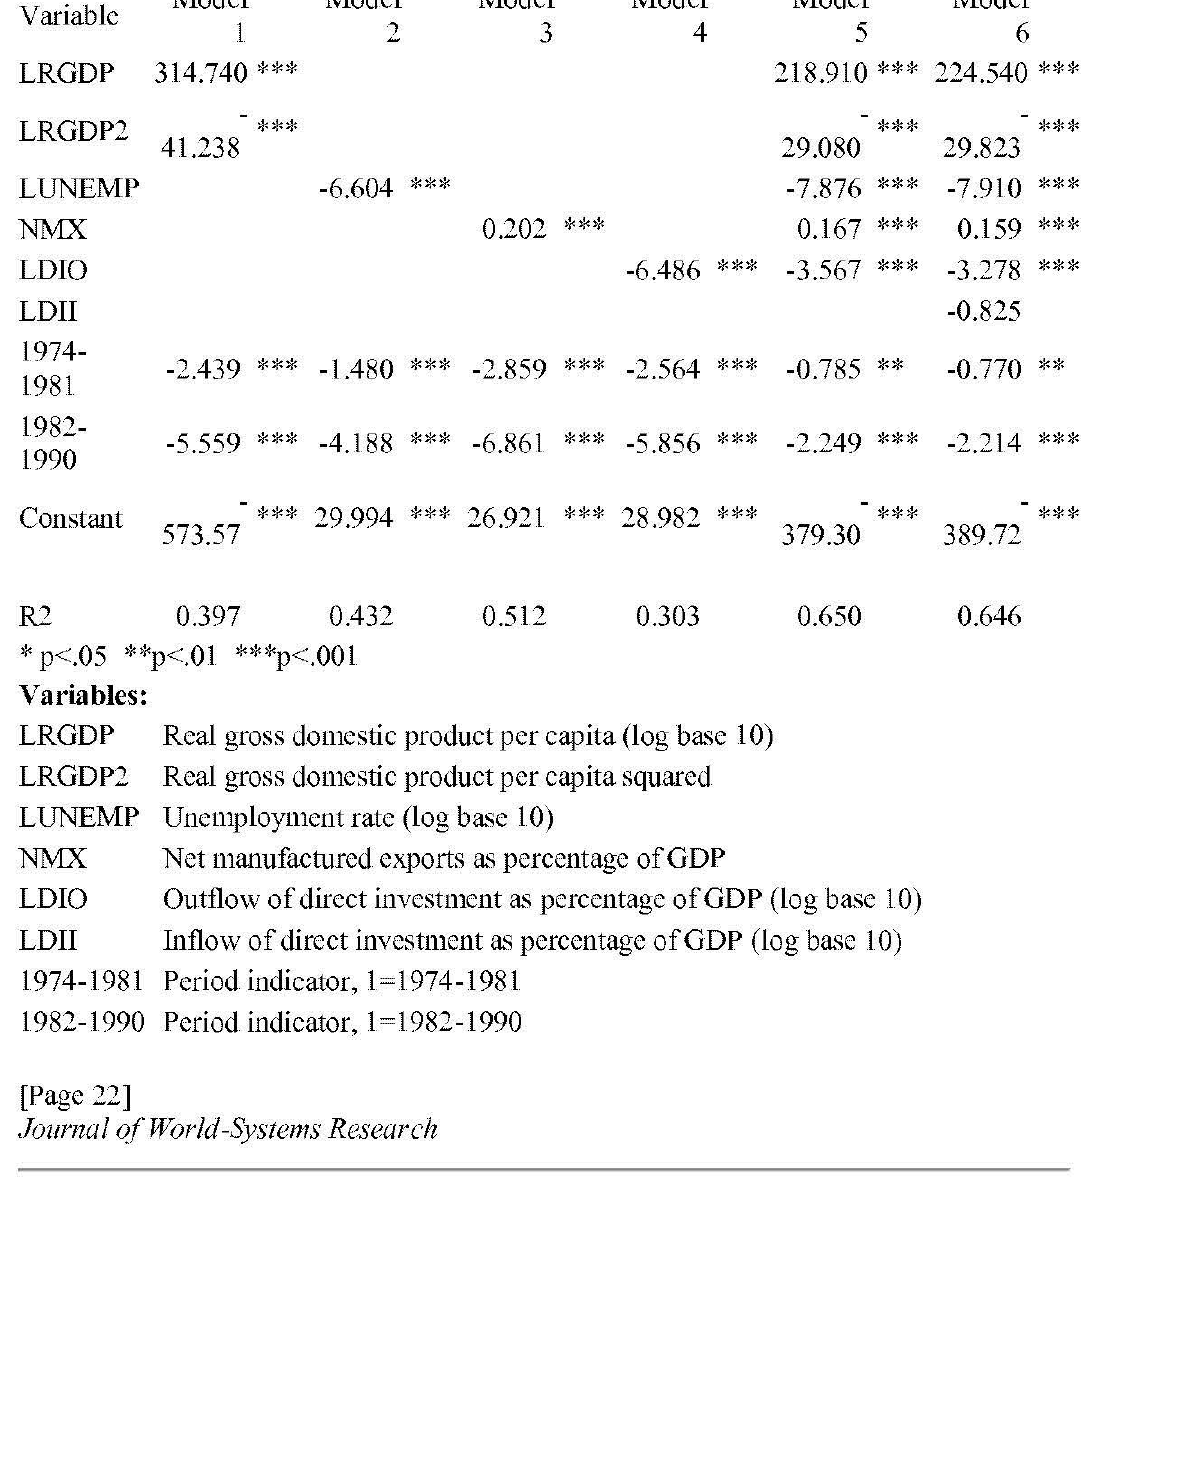
Table 5. Unstandardized coefficients for the regression of percent labor force in manufacturing on selected independent variables: random effect model estimates for 17 OECD nations, 1967-1990 (N=408) Model Model Variable